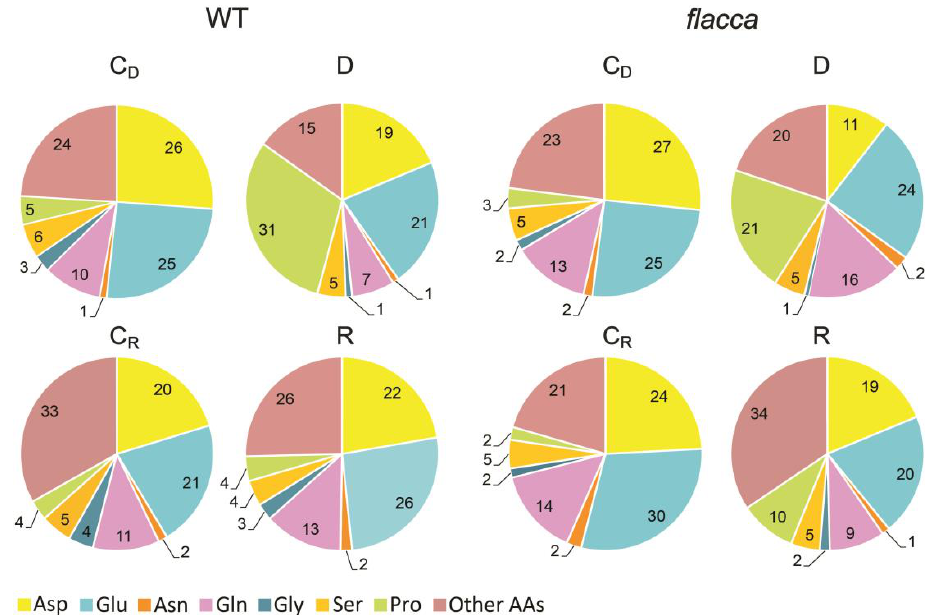
Figure 5. Distribution of free amino acids (AAs) (%) in the leaves of WT and flacca tomato genotypes subjected to six day water deficit (D) and six day re-watering (R) period. Respective controls corresponding to water-deficit condition (C D ) and re-watering (C R ) are presented. Values are presented as means and standard errors were below 20% ( n = 4). The abbreviations are explained in Figure 4.